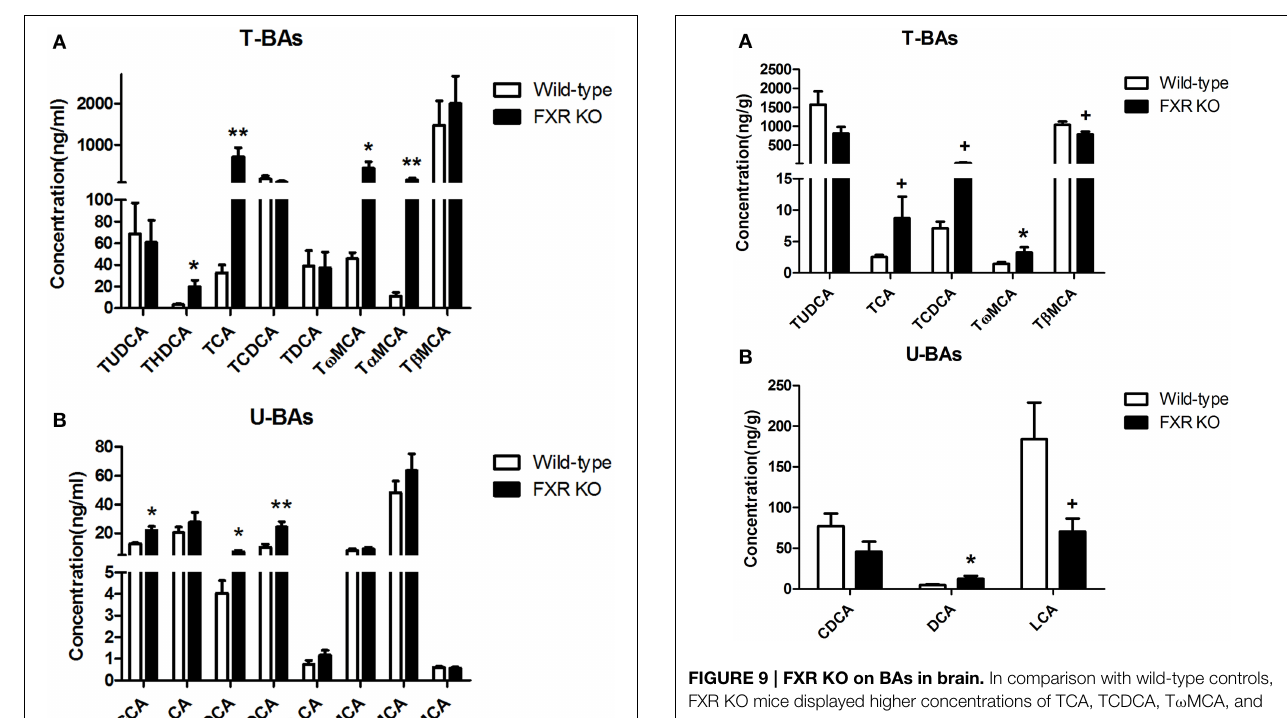
5-HT1A, and SLC6A2, were unchanged by FXR deletion. How-